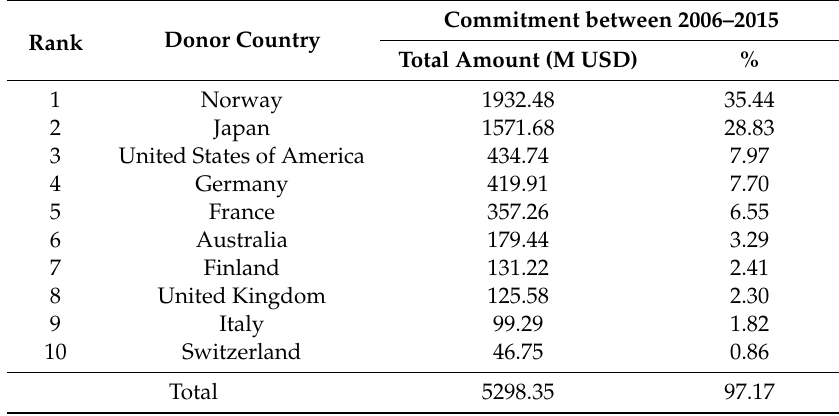
Table 4. The amount of financing commitment and the associated ranking of the donor countries